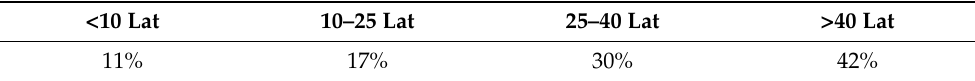
Table 1. Age structure of the analysed 110 kV